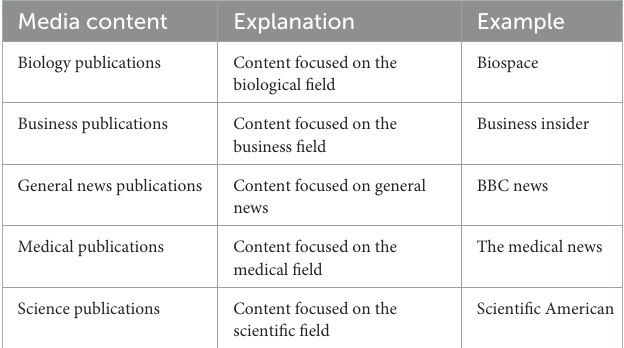
TABLE 2 Definitions of media content.